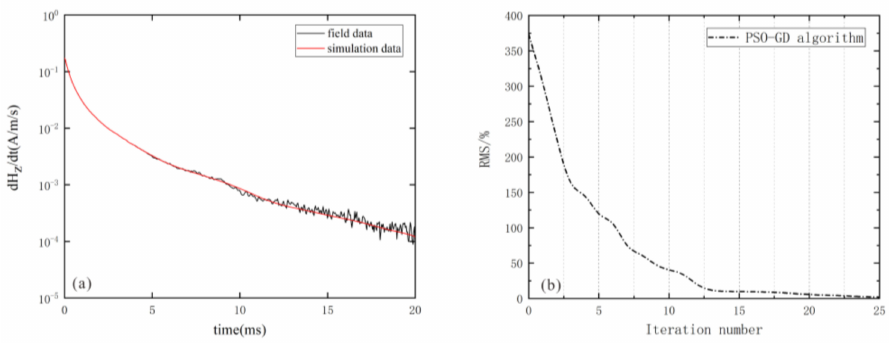
Figure 15. Field data fitting. ( a ) Data fitting. ( b ) Fitting error